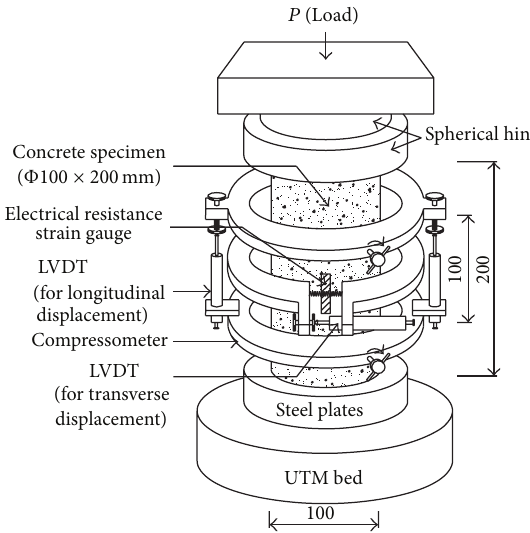
Figure 1: Test setup and instrumentation for test region (all dimensions are in